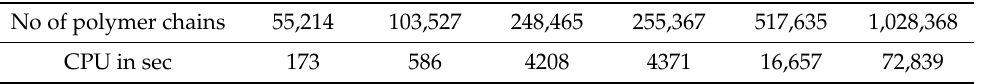
Table 3. Effect of the initial sample size on the computational time needed for the kinetic simulation of crosslinking of the HA-Tyr chains with 0.124 units/mL HRP and 728- µ M H 2 O 2 and PDI = 1 [8]. No of polymer chains